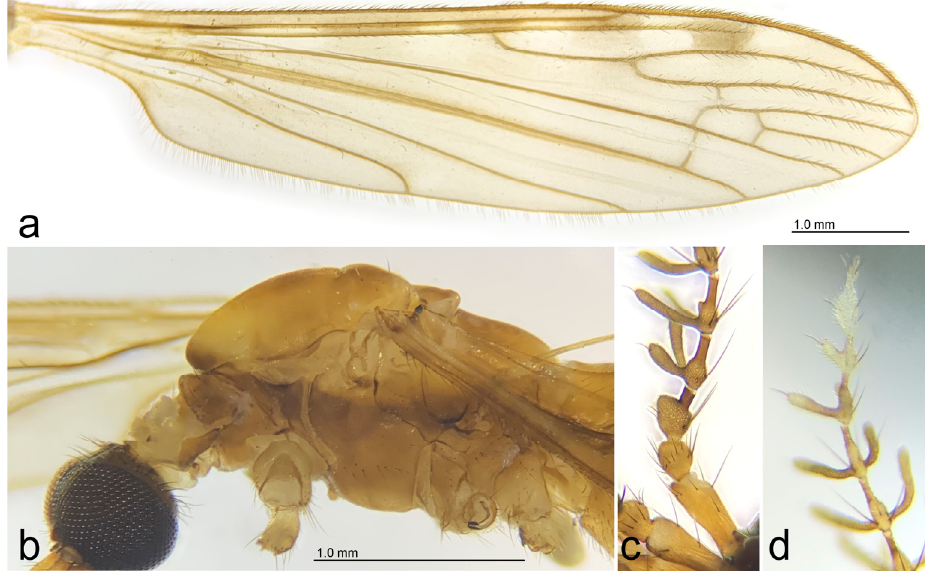
Figure 5. Rhipidia (Rhipidia) martiniquensis sp. nov., holotype male; ( a ) Right wing; ( b ) Head and thorax, lateral view; ( c ) Antenna, basal segments; ( d ) idem , apical segments.